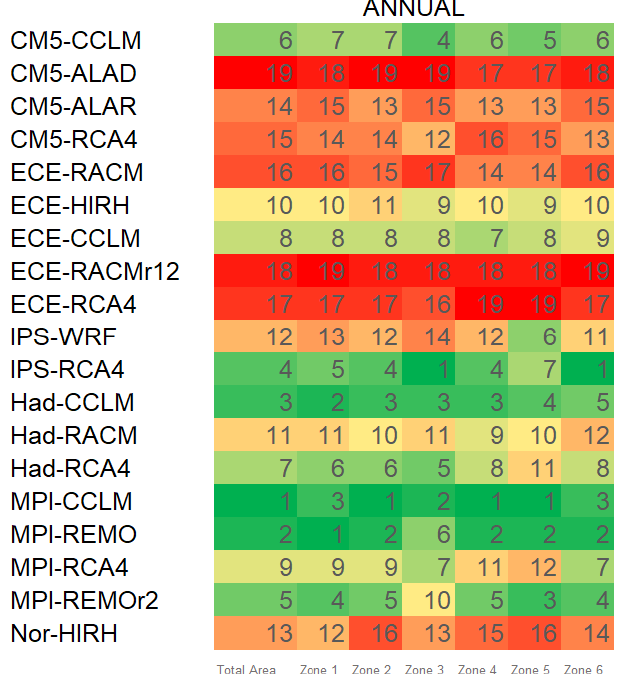
Figure 3. RCM ranking with respect to inter-annual variability of mean temperature, for the entire area and the climatically homoge- nous